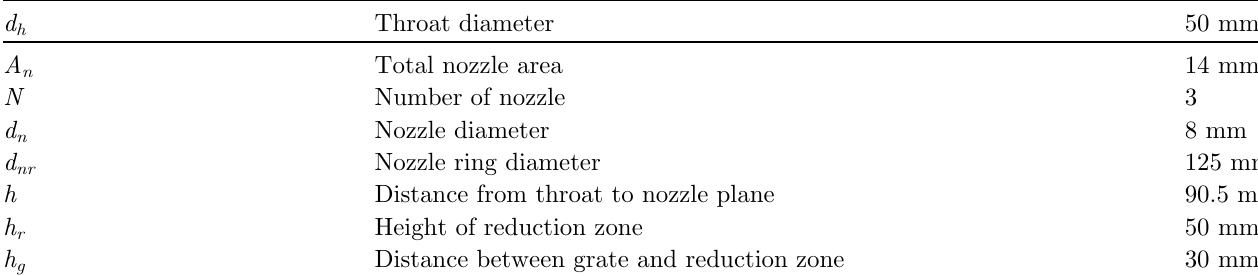
Table 2. Values of the geometric parameters of the gasi fi er.